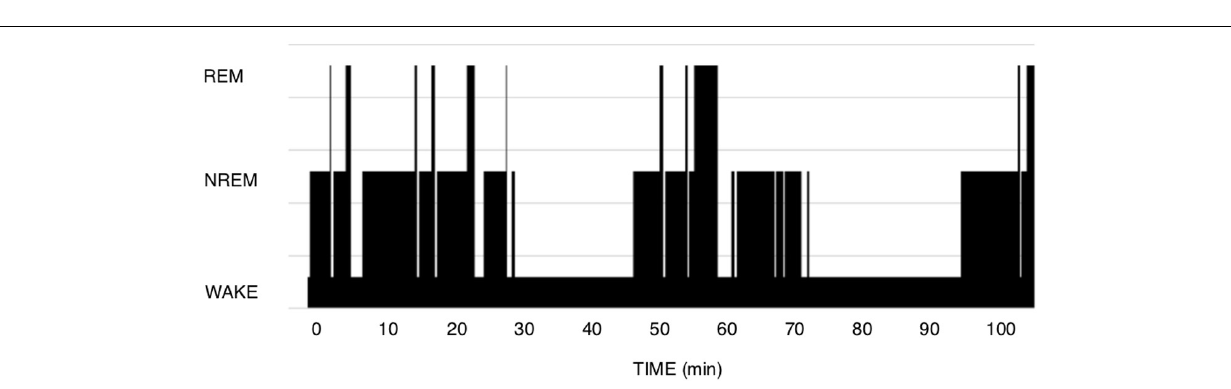
FIGURE 2 | Mouse polysomnogram. CD1 mouse, 7 months old. We observe here a large variety of inter-REM intervals as well as an intercurrent mix of long Wake episodes, irregular sequences, isolated NREM episodes. In comparison to human hypnograms, it is more difficult here to detect the positive relationship between the duration of a REM episode and the inter-REM